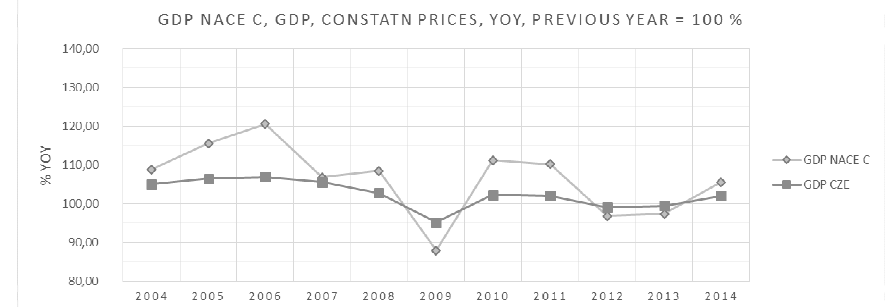
Fig. 2 - Czech GDP and GDP industrial production (NACE C) 2004-2014, constant prices. Source: CZSO